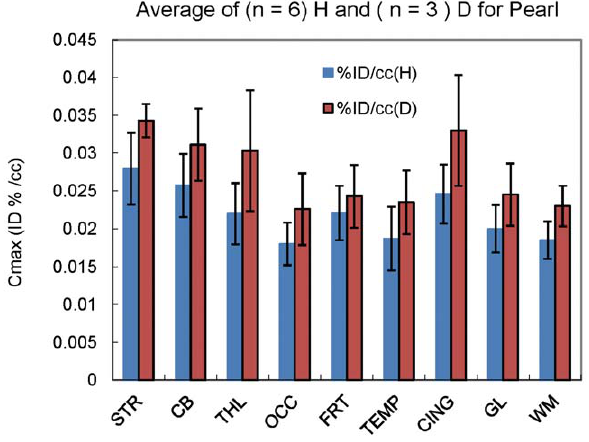
Figure 4. Brain uptake (C max ) of tracers 1 (H) and 2 (D) in baboon (Pear) in different brain region. STR: Striatum; CB: Cerebellum; THL: Thalamus; OCC: Occipital cortex; FRT: Frontal cortex; TEMP: Temporal cortex; CING: Cingulate gyrus; GL: Global; WM: White matter. Tracer 2 shows consistent higher uptake than 1 in all brain regions.